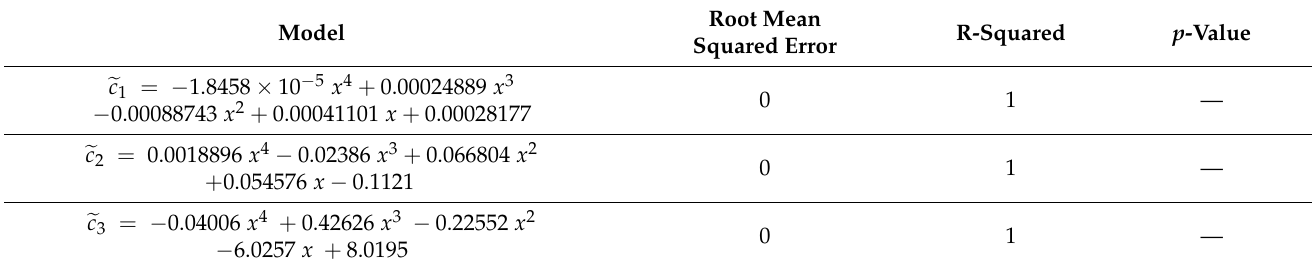
Table 24. Models (for parameters (cid:101) c 1 , (cid:101) c 2 , and (cid:101) c 3 ) and statistics (procedure 6). Model